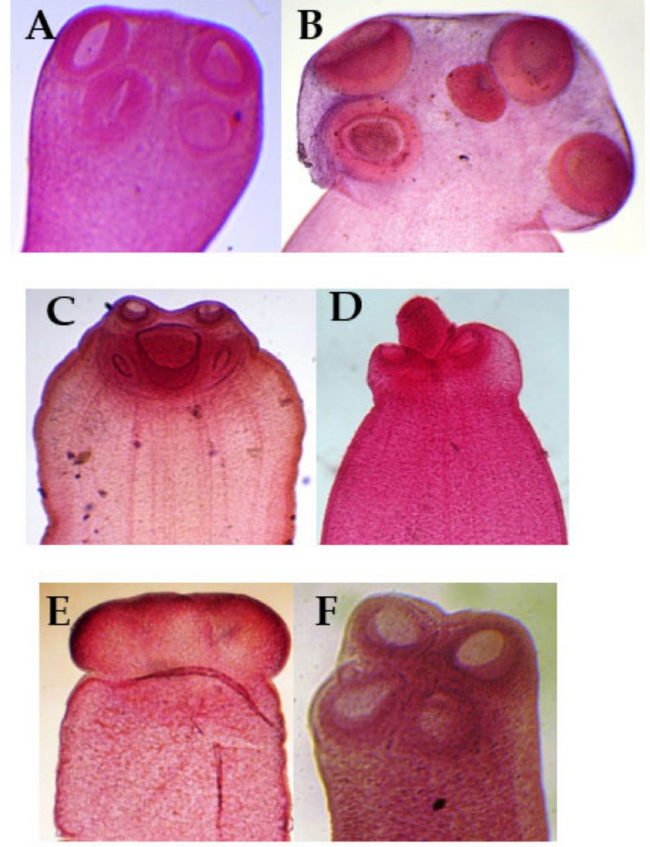
Figure 3. ( A – F ) Scoleces of larval cestodes encysted in the viscera of anuran hosts in Nigeria. ( A ) Proteocephalus sp. in S . regularis ; ( B ) Proteocephalus sp. in Arthroleptis poecilonotus ; ( C ) Proteocephalus sp. in Ptychadena bibroni , P . pumilio , P . mascareniensis , H . occipitalis , S . tropicalis and several tree frogs; ( D ) Proteocephalus sp. in A . galamensis ; ( E ) Proteocephalid cestode in H . occipitalis ; ( F ) Ophiotaenia sp. in A . poecilonotus